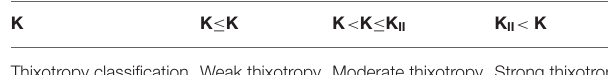
TABLE 4 | Classification standard of clay